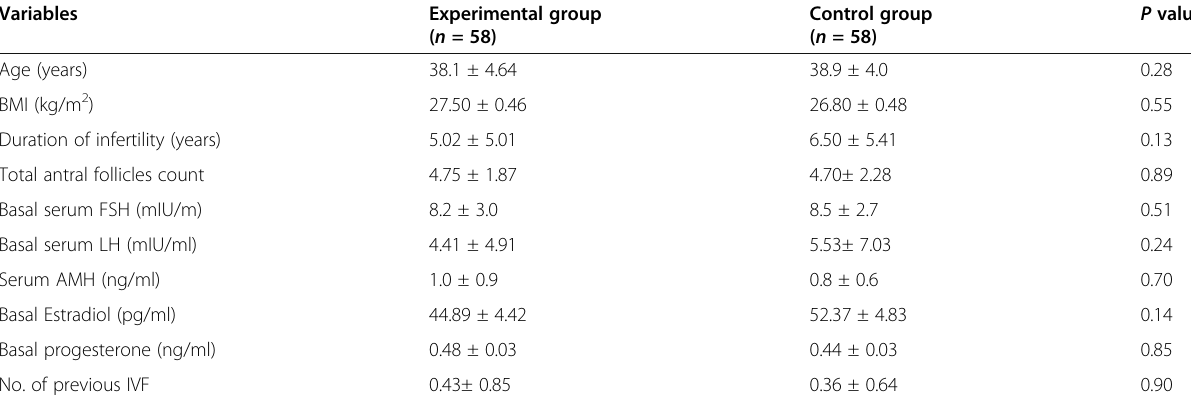
Table 1 The patients ’ characteristics in the study